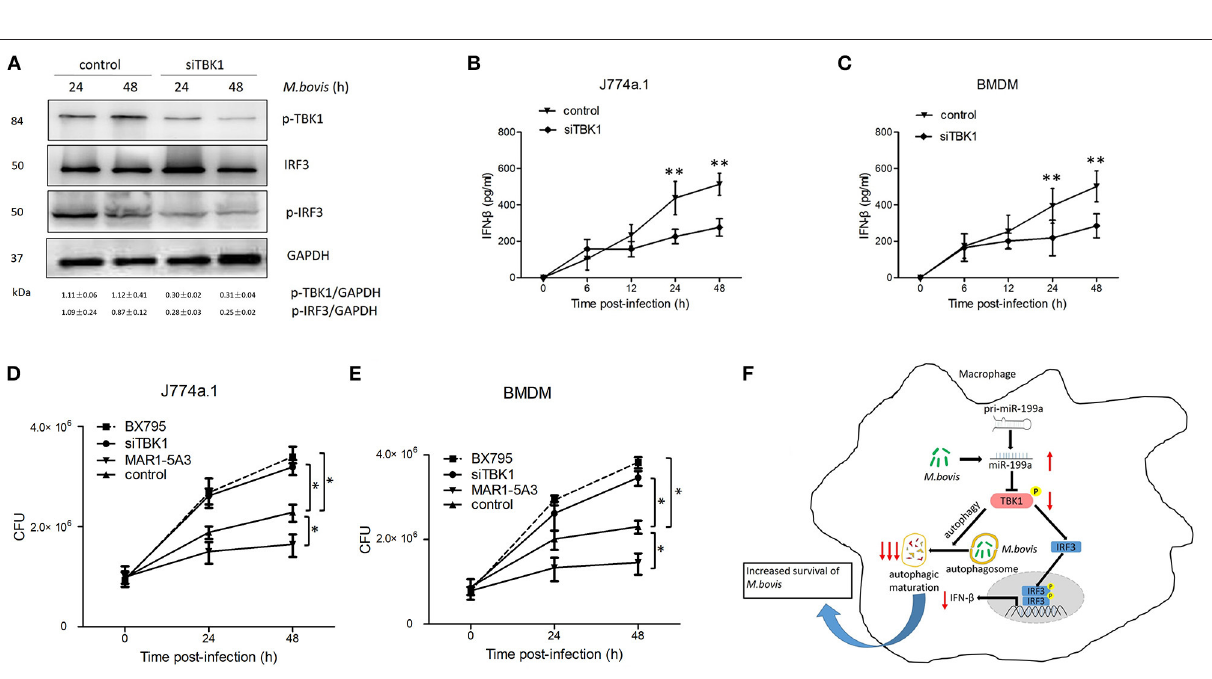
FIGURE 5 | were infected with M. bovis at a MOI of 10 for 0 or 24h. Nuclear and cytosolic extracts were examined by immunoblotting with anti-IRF3 antibody at different infection times (4, 24h). These membranes were stripped and immunoblotted with anti- β -actin and anti-TATA binding protein (TBP) antibodies to examine the purity of nuclear (right) and cytoplasmic (left) lysates. The IRF3/ β -actin and IRF3/ β -actin ratios are shown below. (I, J) J774a.1 cells were treated with control, miR-199a mimic or inhibitor and then infected with M. bovis at a MOI of 10 for 24 or 48h. Quantitative analysis of the TBK1, phosphorylated TBK1 (p-TBK1), IRF3 and